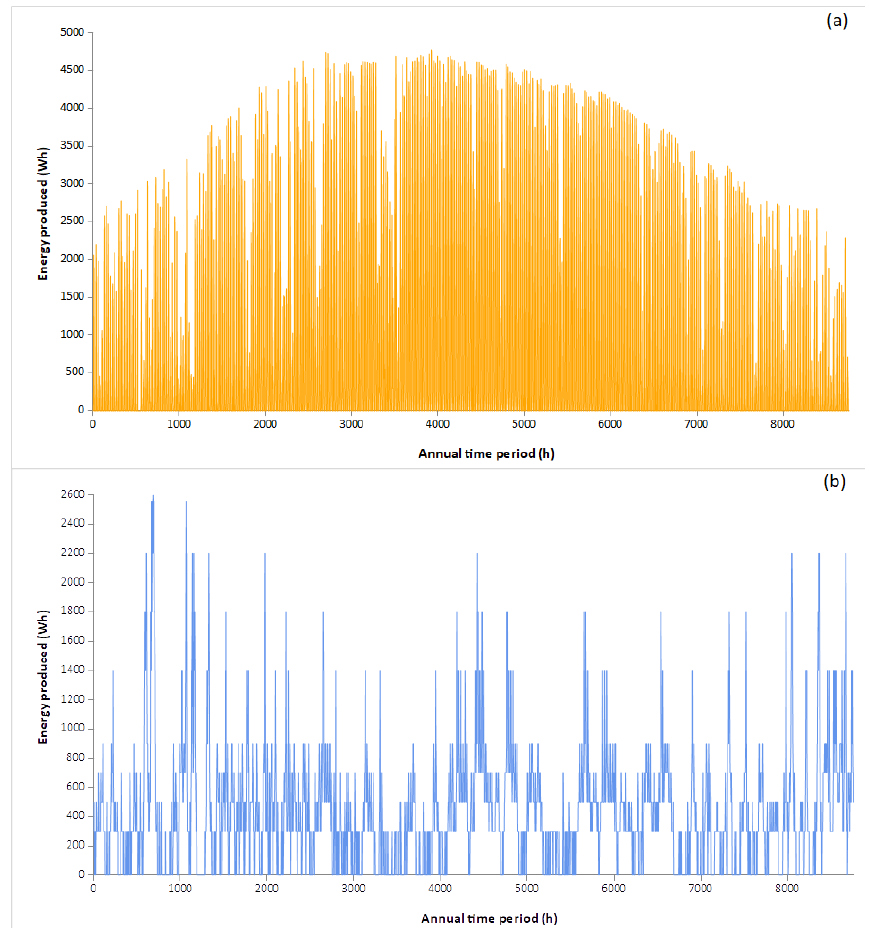
Figure 5. Time series of the energy produced by the optimal configuration from ( a ) photovoltaics and ( b ) wind turbines.